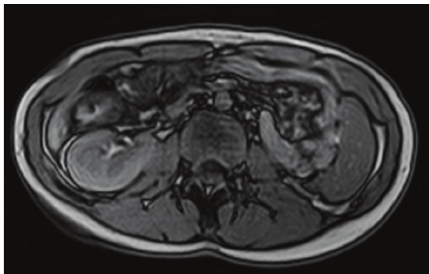
Figure 2: 11-year-old adolescent female with left-to-right crossed renal ectopia. Axial RM scan demonstrates two normal enhancing kidneys on the